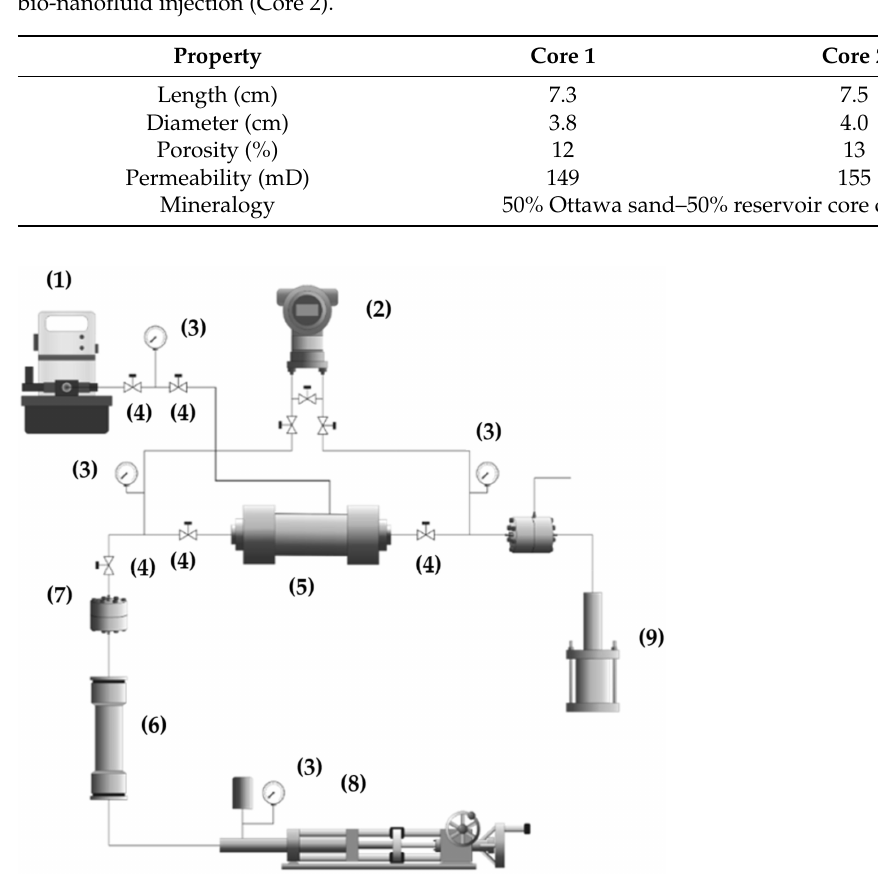
Figure 3. Schematic representation of the experimental setup for displacement tests at reservoir condition: (1) Hydraulic pump, (2) pressure transducer, (3) manometer, (4) valves, (5) coreholder, (6) cylinder, (7) filter, (8) displacement pump, and (9) pressure multiplier. Adapted with permission from Franco et al. [38], Nanomaterials ; published by MDPI,